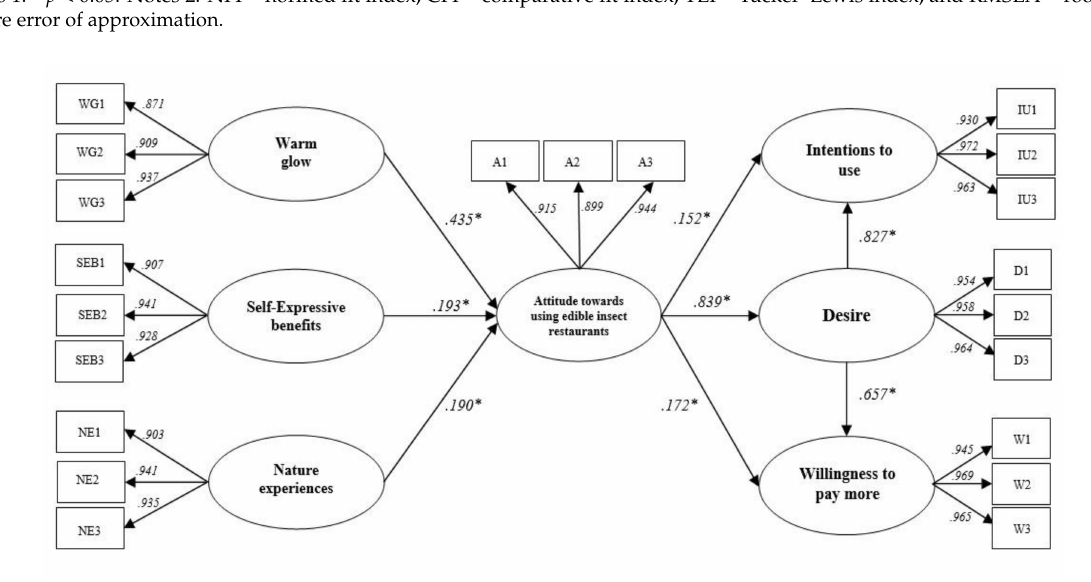
Figure 2. Standardized theoretical path coefficients. Note: * p <